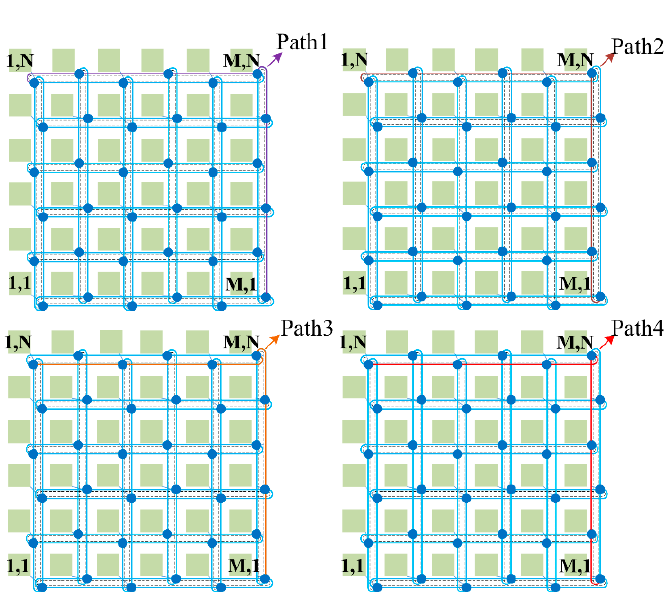
Figure 5. Different paths among the first longest links. Figure 5. Di ff erent paths among the first longest